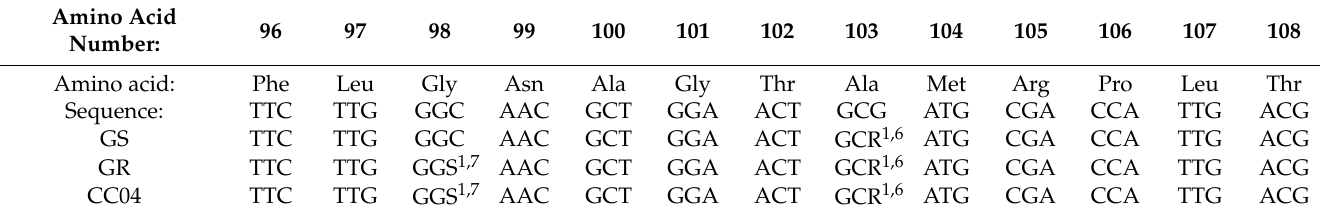
Table 3. Aligned nucleotide sequences of the conserved region of EPSPS for populations of Lolium rigidum . Amino acids are numbered according to Baerson et al. (2002). 1 Silent mutation, 2 Missense mutation, 3 Y = T or C, 4 K = G or T, 5 W = A or T, 6 R = A or G, 7 S = G or